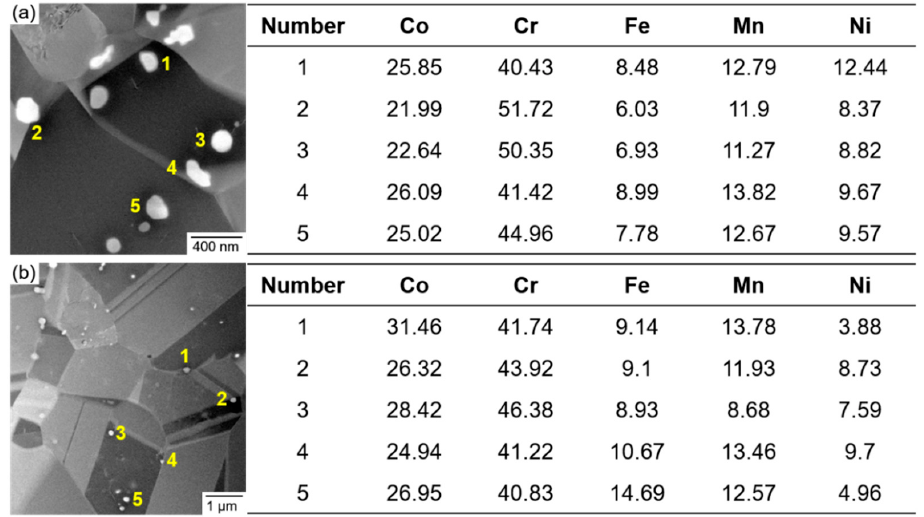
Figure 3. STEM HAADF image and the EDS analysis of the ( a ) cold-rolled and heat-treated at 973 K for 30 min (HT1) and ( b ) 1023 K for 30 min (HT2) Co 35 Cr 25 Mn 15 Ni 15 Fe 10 HEA.